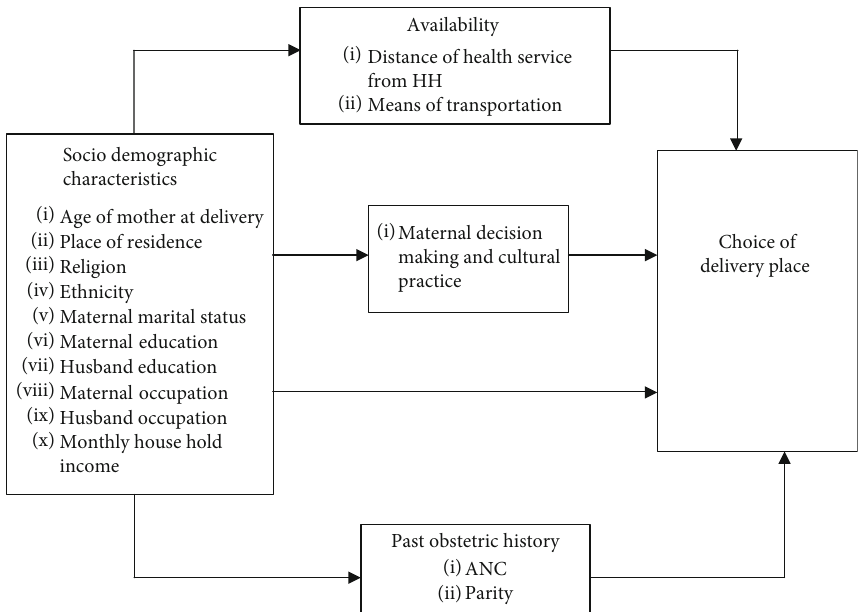
Figure 1: Conceptual framework for analyzing the determinants of maternal choice of birthplace (adapted from Sayih [19]).